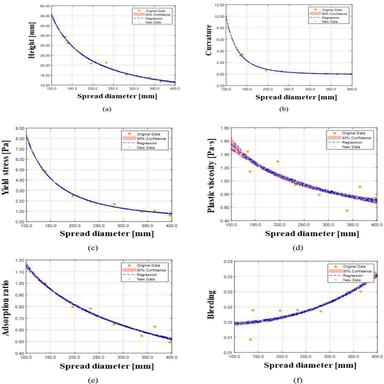
Generation of new data based on regressions of experimental results: diameter vs (a) height, (b) curvature, (c) yield stress, (d) plastic viscosity, (e) adsorption ratio, and (f) bleeding.